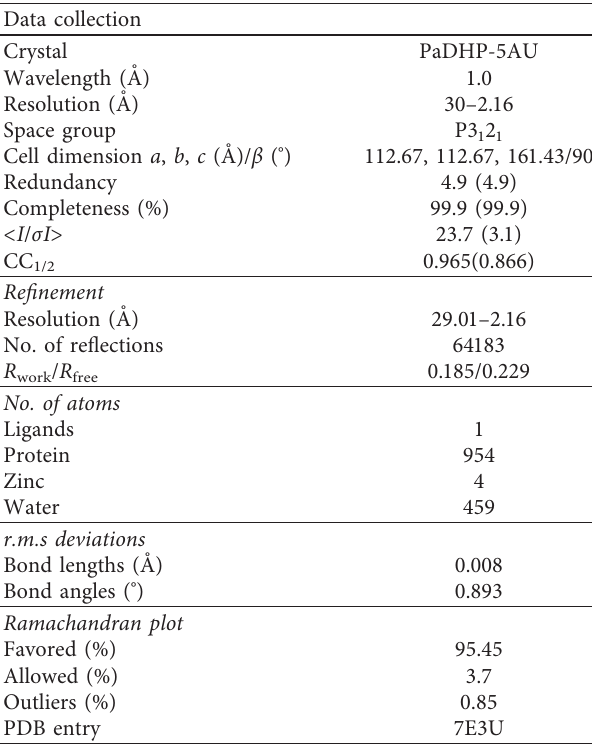
Table 2: Data collection and refinement